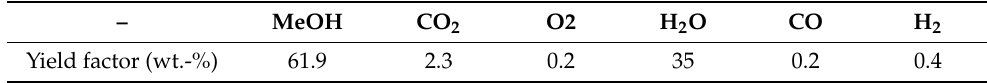
Table 1. Yield factors of methanol reactor, derived from Wassermann et al. [18]. – MeOH O2 CO H 2 Yield factor